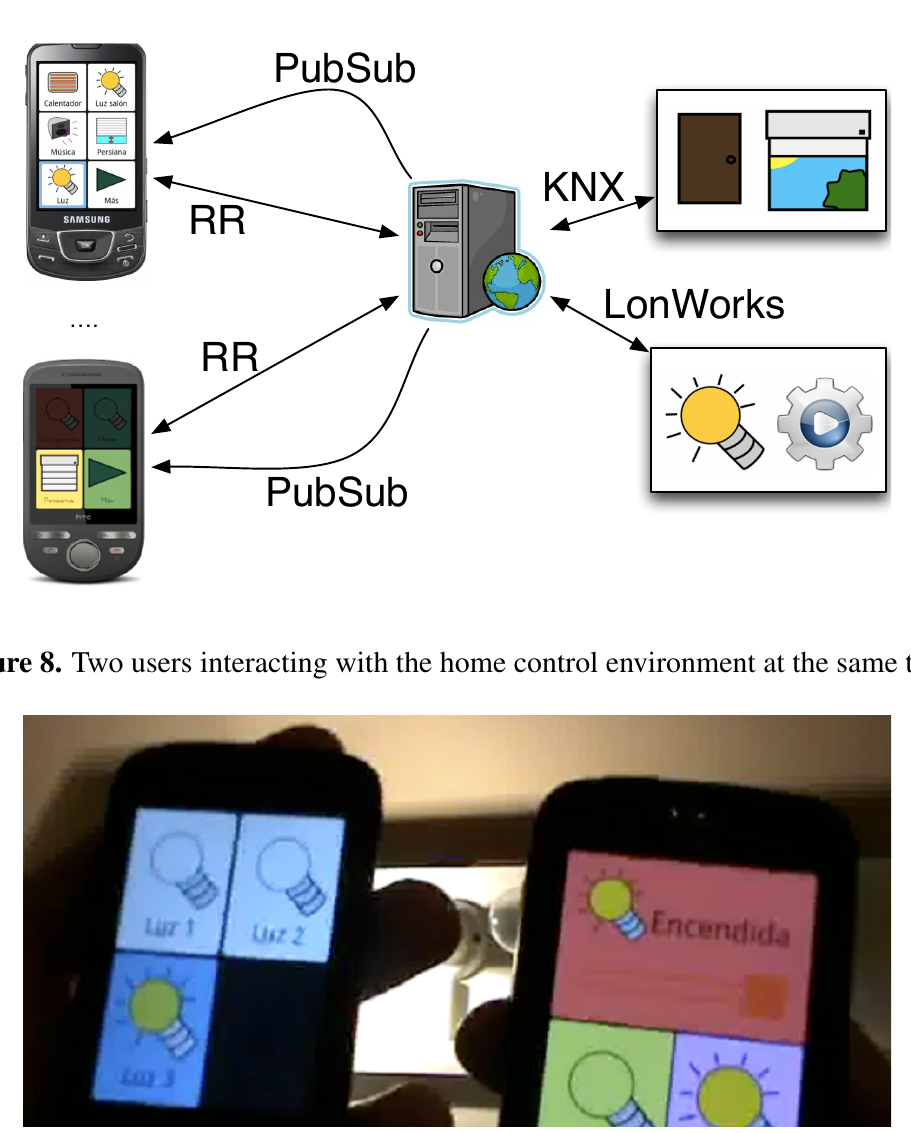
Figure 7. Architecture of the home automation system.